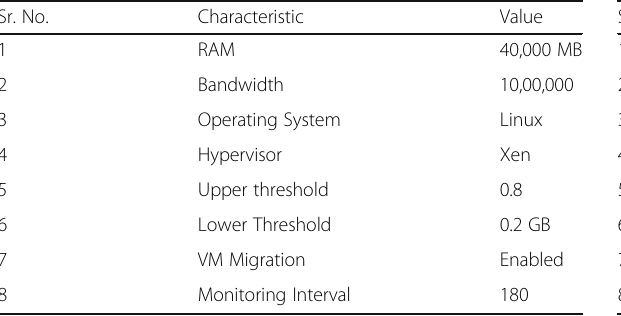
Table 12 Host configuration details